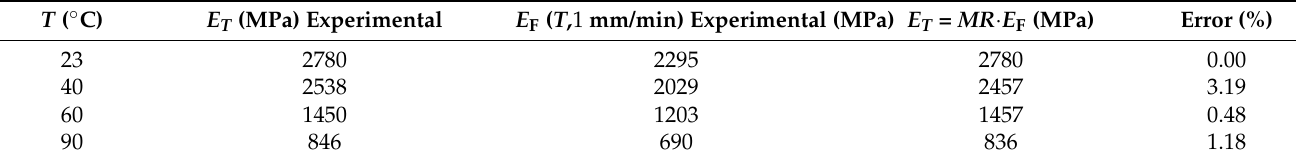
Table 3. Tensile modulus: experimental and predicted by the moduli ratio.